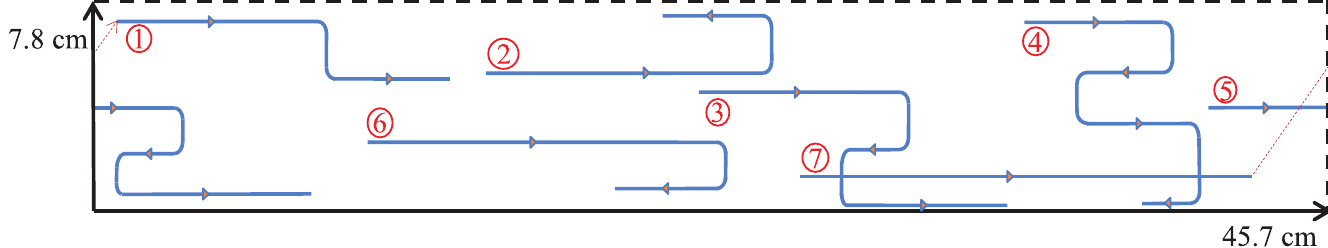
Fig 2. The curve path used in ME. For different experimental conditions the sequence of the curves are changed in order to prevent subjects from memorizing the order. The curve path is printed on a paper and wrapped around the rotating disc. Curves are given in the same aspect ratio as they are seen on the rotating wheel. This figure is 1:2 reduced in dimension to fit the margins. As the wheel rotates clockwise, curves flow from right to left. Each curve is designed such that tracking the curve with the index finger imitates reading of a short Braille sentence. The parts of the curve with arrows pointing left mimic reversals observed during Braille reading. Subjects start tracking with the first curve (marked with red circle), and proceed with the next one. After completing seven distinct curves, they repeat tracking the same path. The red arrow at curve 7 guides the subject to proceed to curve 1, to repeat the